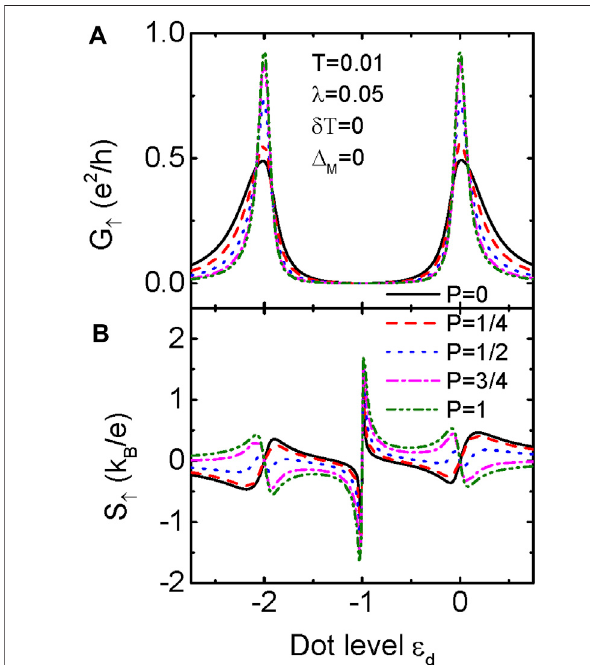
FIGURE 2 | G ↑ in (A) and thermopower S ↑ in (B) as functions of system equilibriumtemperature T forthegiven parameters. Thethermpower changes sign by varying the temperature with the help of the